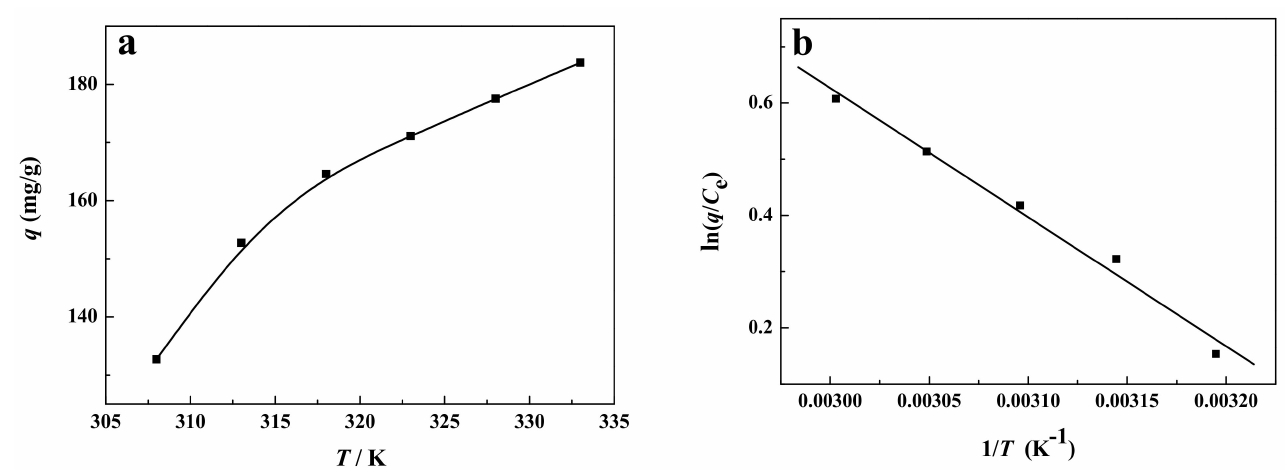
Figure 9. ( a ) Effect of adsorption temperature on removal of dye and ( b ) ln( q / C e ) - 1/ T curve. According to the line slope − ∆ H / R , the enthalpy changes ∆ H = 19.098 kJ/mol